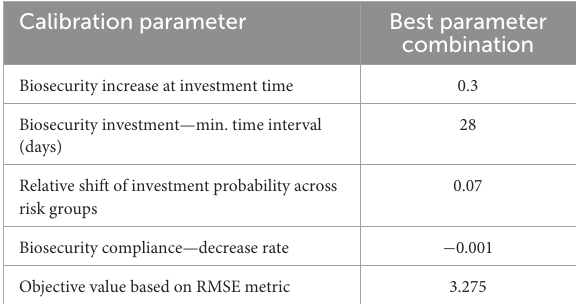
TABLE 5 Model calibration results: Optimized values for four parameter values linked to human behavior.